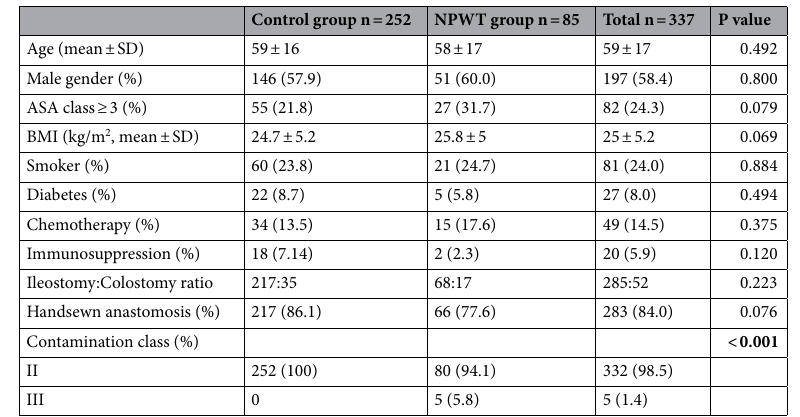
Table 1. Demographics and surgical details. Baseline demographic parameters of patients before and after implementation of NPWT wound device. SD—standard deviation, ASA—American Society of Anaesthesiology, BMI—body mass index. Age and BMI are presented as mean ± standard deviation (SD). All others are frequency with percentage. Bold P values indicate statistical significance ( p < 0.05).